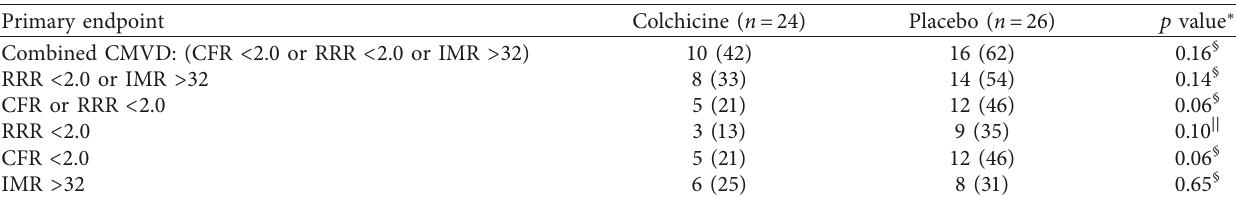
Table 4: Primary study endpoint, by study drug